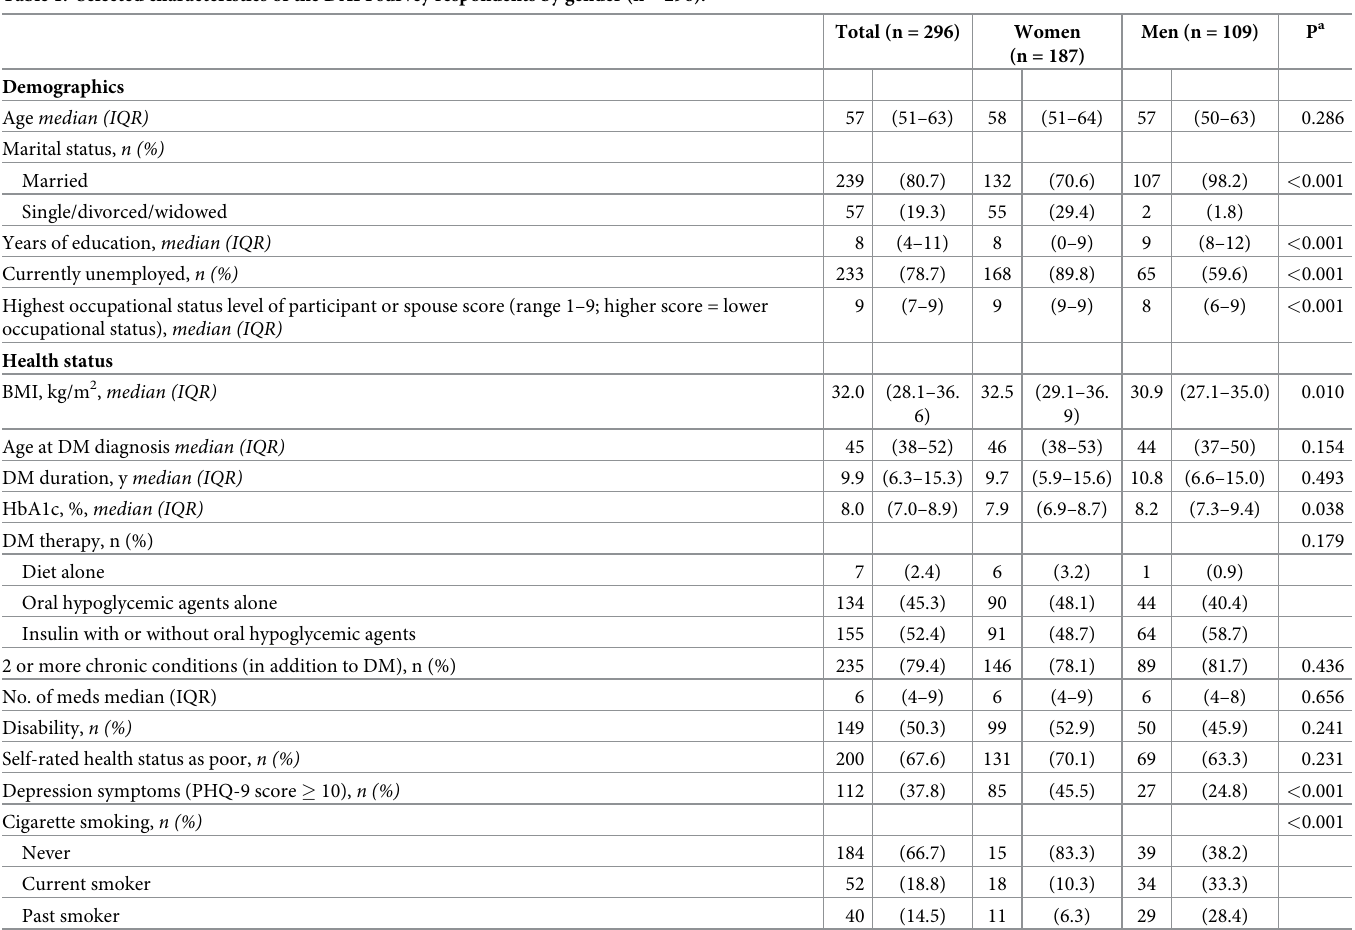
Table 1. Selected characteristics of the DAPI survey respondents by gender (n =